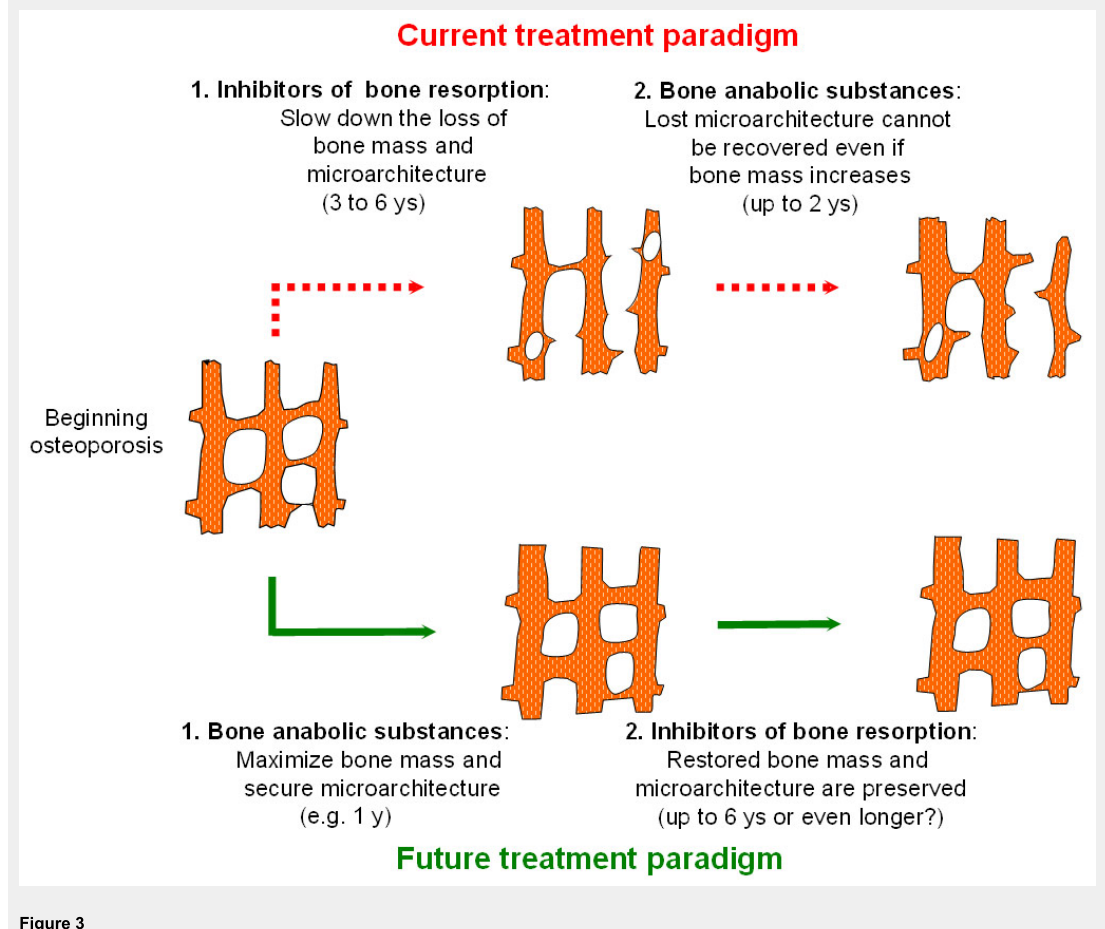
Figure 3 Current and future treatment paradigm of osteoporotic bone loss of bone mass and microarchitecture. According to the current treatment paradigm, antiresorptive drugs are the mainstay first line therapy for reducing fracture risk in patients with osteoporosis and anabolic substances are usually recommended in patients with severe osteoporosis only. As lost bone microarchitecture cannot be recovered, a future treatment paradigm may aim at reversing osteoporosis by maximising bone mass and preserving bone microarchitecture during the early phase of disease progression, the achieved gains being preserved by an inhibitor of bone resorption used in a second